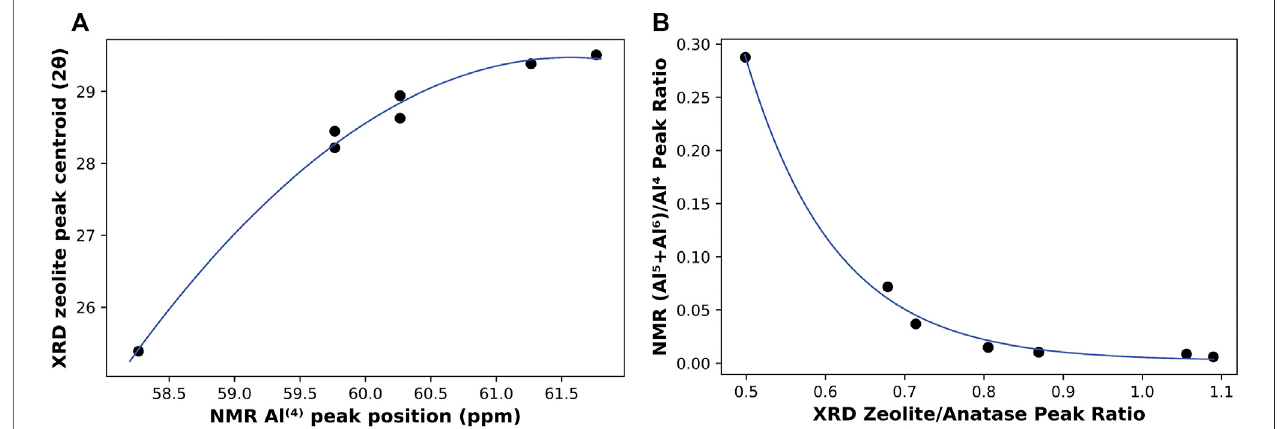
FIGURE 10 | A correlation between NMR (4 month old samples) and XRD (3 month old samples) results. (A) shows the relationship between Al (4) peak position (ppm) referenced to Al(NO 3 ) 3 solution and XRD centroid of zeolite hump (2 θ ), and (B) shows the ratio of NMR ’ s (Al (5) +Al (6) )/Al (4) compared to the ratio of zeolite/anatase peaks from